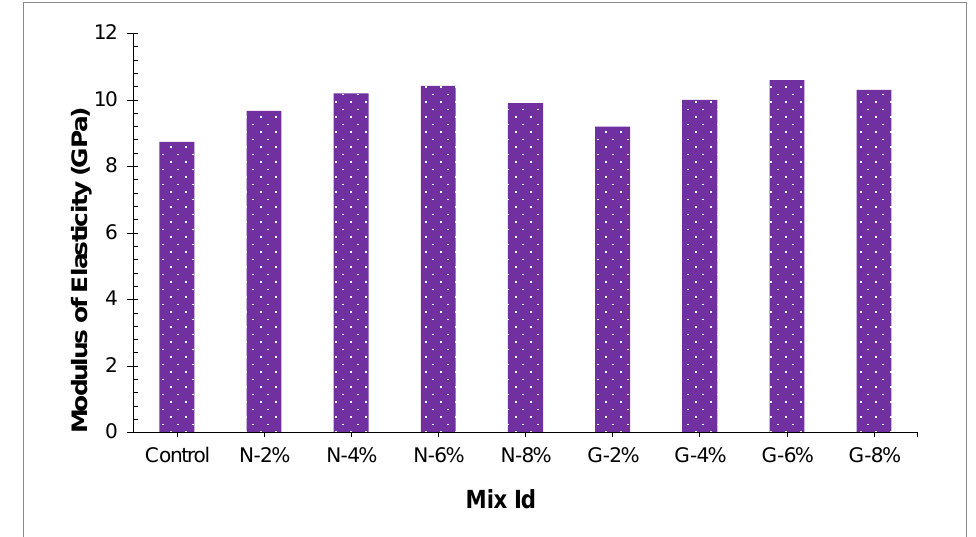
Figure 14. Modulus of elasticity of all concrete samples.